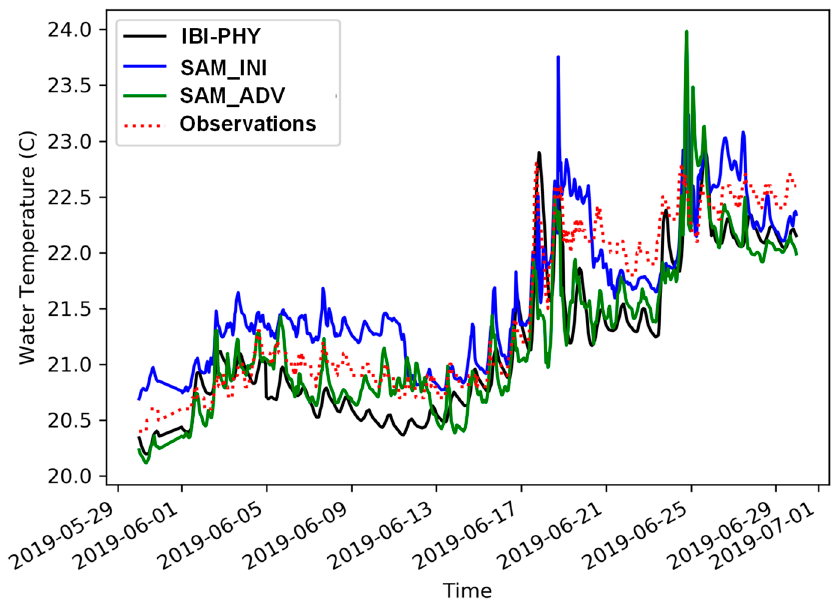
Figure 4. Observed and modelled Sea Surface Temperature (SST) at Gran Canaria PdE EXT mooring buoy (see location in Table 2) in June 2019. Units in Celsius degrees. The dotted red line represents the observations; the solid black line is the parent solution (CMEMS IBI_PHY); the solid blue line is the initial SAMOA set ‐ up (SAM_INI); and the solid green line represents the SAMOA solution obtained with the advanced set ‐ up (SAM_ADV).